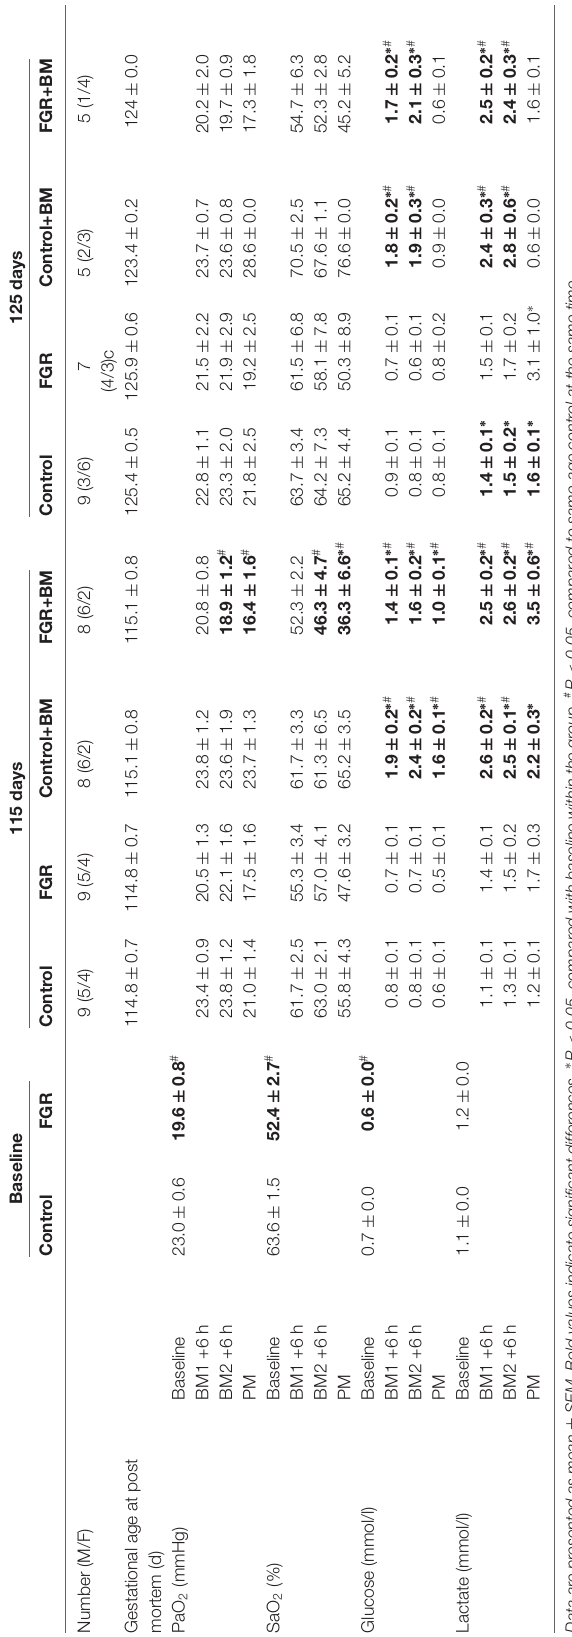
the SCWM ( P = 0.001), corpus callosum (CC; P < 0.001) and PVWM ( P < 0.001). We utilized two staining markers of myelination density within the developing brain, CNPase, and MBP. There was significantly less CNPase-positive myelin in FGR fetuses compared to control within the SCWM ( P = 0.009) and CC ( P = 0.01; Figure 3 ). Betamethasone administration significantly increased CNPase-positive myelin staining in the external capsule (EC; P = 0.02) but did not alter staining in any other region examined. Overall, MBP density was not changed by